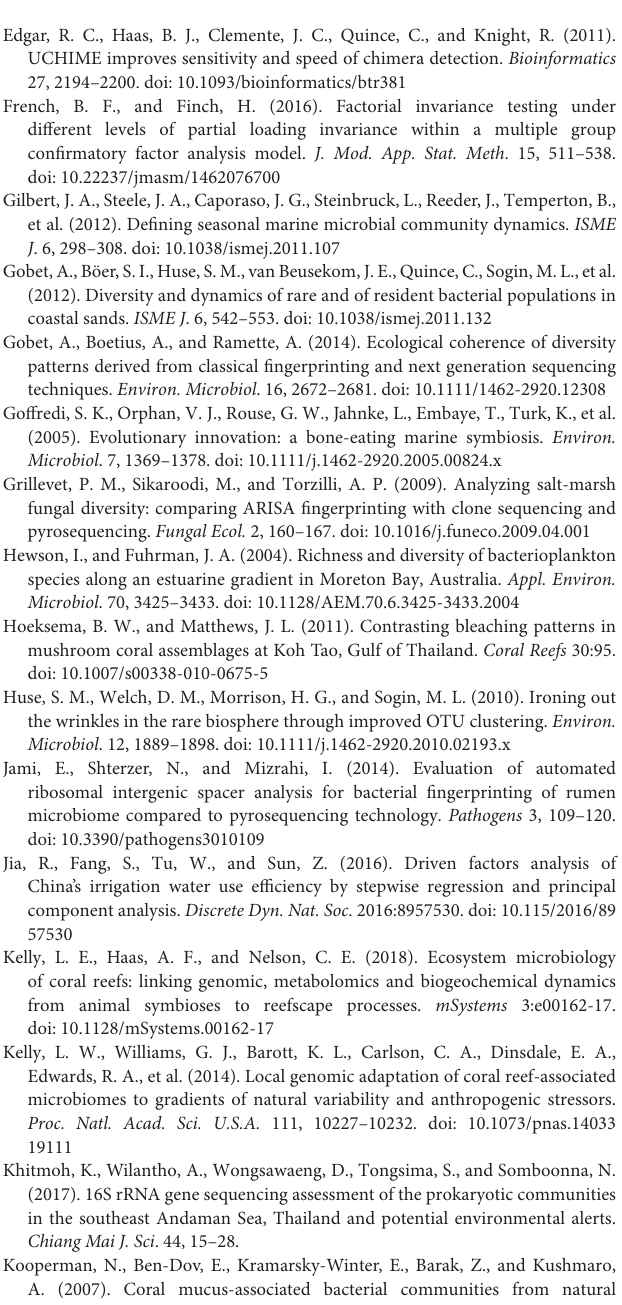
Figure S3 | Complete linkage cluster analysis of corals, sediment and seawater communities, at Ko Samae San, Khao Ma Cho, and Ko Tao Mo fringing reef sites. Figure S4 | A test of significance for profiles clustering by SIMPROF. (A) All B-RISA subgroups and (B) merged subgroups with p > 0.01. Significant clustering ( p < 0.05) is indicated with shared color branches. Table S1 | Estimates of sample coverage and alpha diversity indices at phylum and genus levels of 16S rDNA profiles. Table S2 | List of 147 genus level OTUs predicted by Y 147 = 338.907 + 0.018